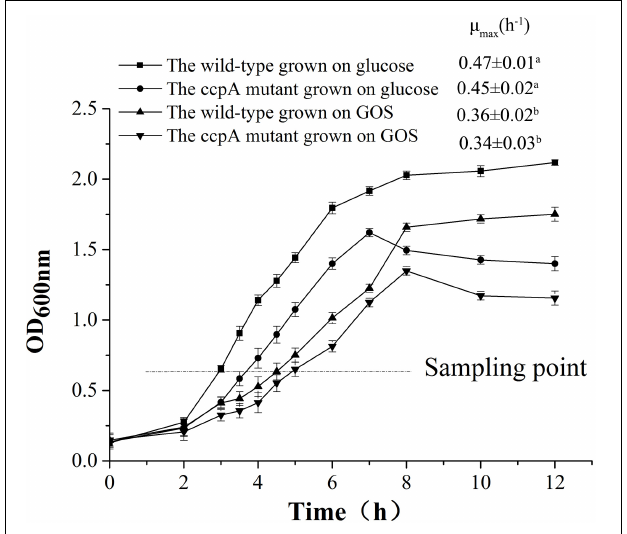
FIGURE 1 | Growth of the wild-type and ccpA mutant in a CDM supplemented with 1% commercial GOS and glucose. A sampling point was chosen for the transcriptome analysis, metabolite measurement, and RT-qPCR analysis. The µ max for each condition were also calculated and are shown in the figure. Data presented are mean values based on three replicate fermentations. Error bars indicate standard deviations. Values marked with different lowercase superscript letters (a,b) indicate that they are significantly different ( p < 0.05) from other